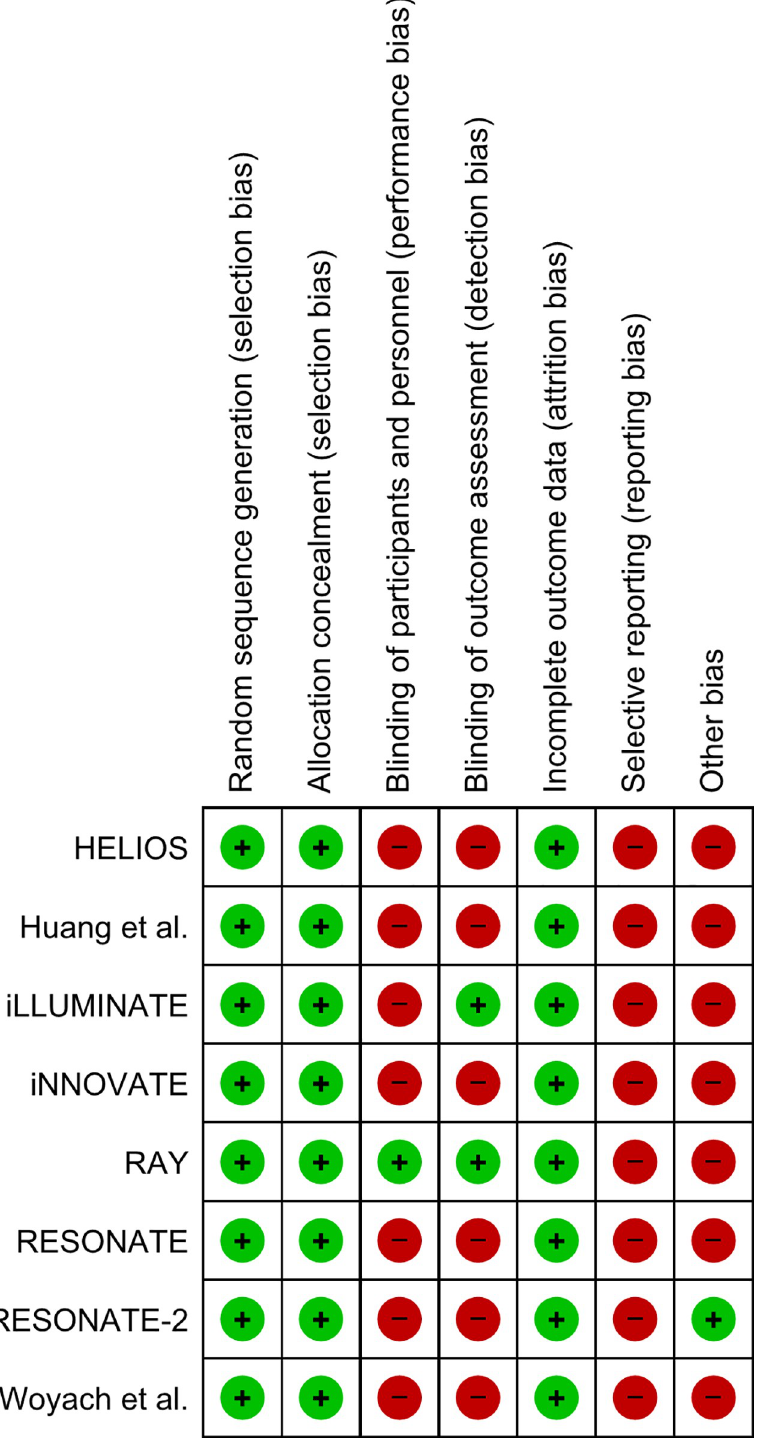
Fig 2. Risk of bias plot of included